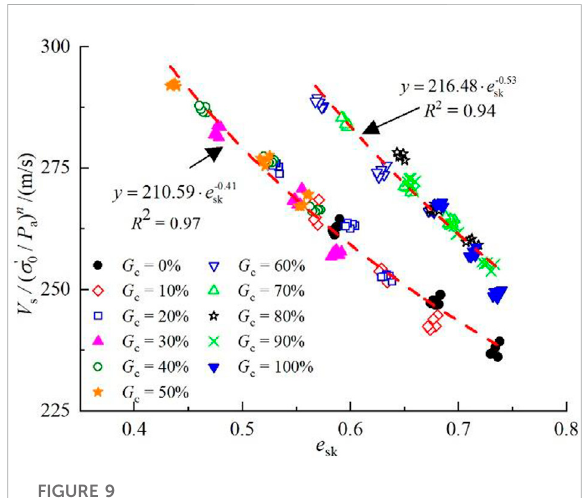
FIGURE 9 Relationship between the normalized shear wave velocity and e sk of the